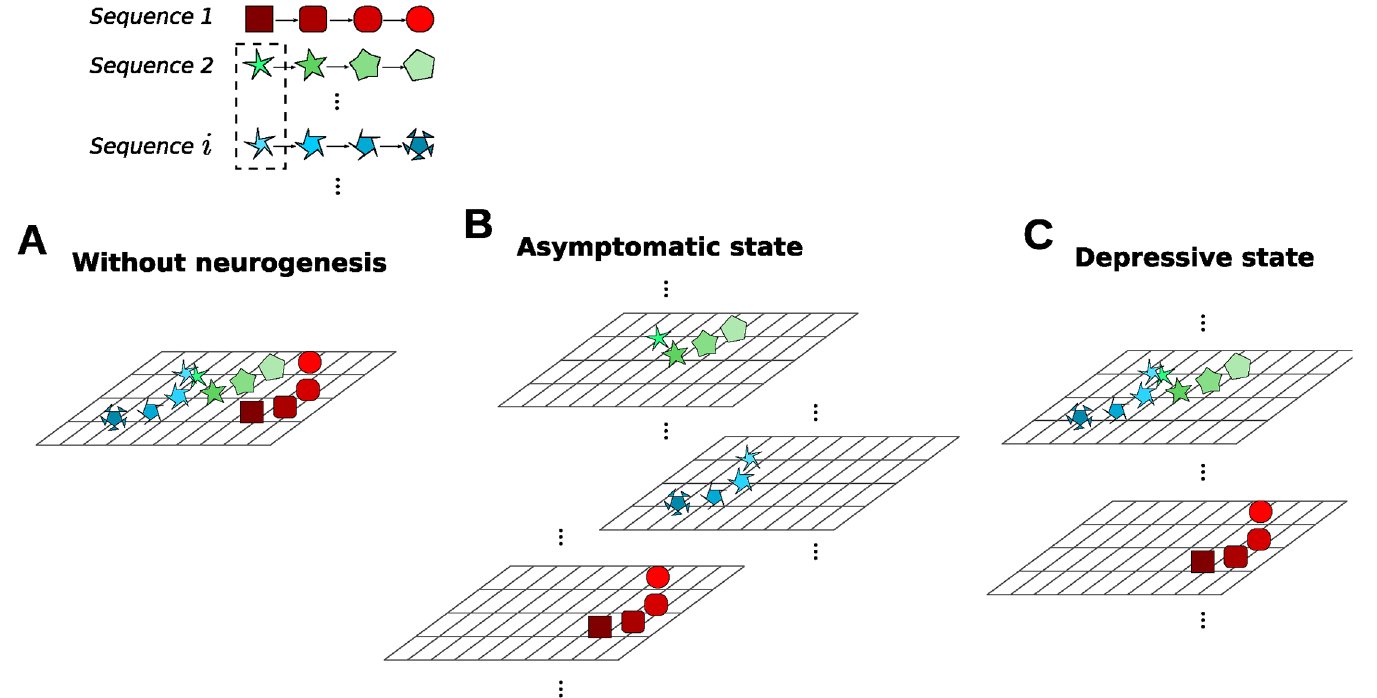
Fig 2. Illustration of the role of adult neurogenesis in the dentate gyrus. Top: Schematic of three stored sequences in the memory model, where the first elements in sequences 2 and i are similiar to each other. A: Without adult neurogenesis, the memory patterns are located in close proximity to each other in the memory space. B: In the asymptomatic state with a normal rate of adult neurogenesis, the augmentation with distinct pattern separation vectors distributes the sequences along an additional dimension in memory space. C: In the depressive state, the new sequence ( i ) is stored by re-using a pattern separation vector that had been assigned to a memory stored in a preceding asymptomatic state, based on the similarity of their first patterns. As a result, the two memory sequences, 2 and i , are more likely to interfere during retrieval.